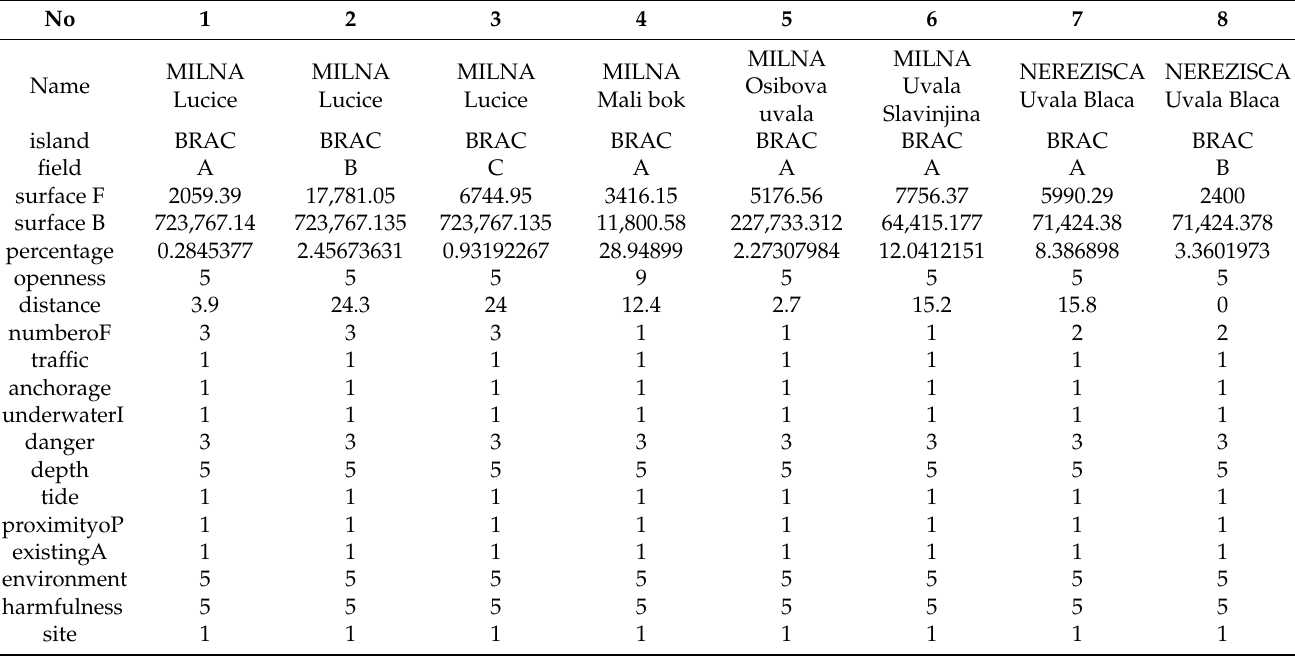
Table 4. Excerpt from collected data on the first eight locations of nautical